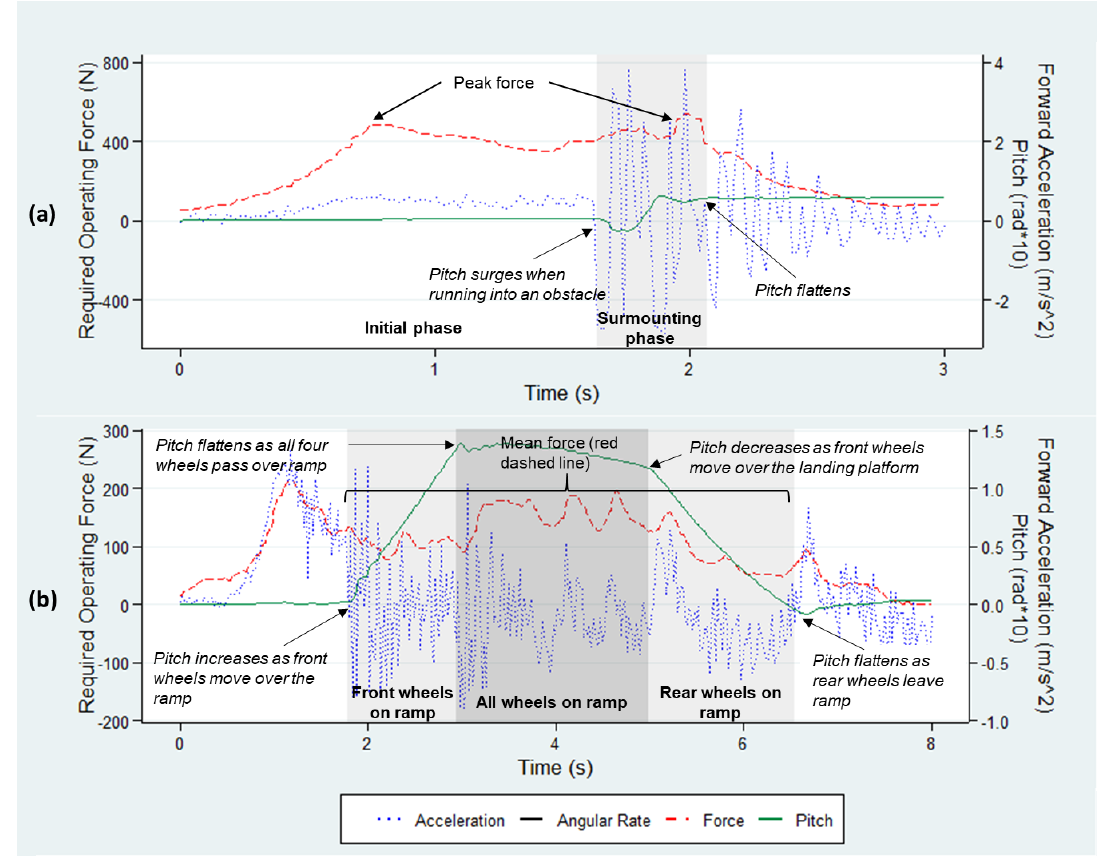
Figure 7. Sample trial data: ( a ) obstacle track within a moderately constrained space and ( b ) ramp track within a severely constrained space.